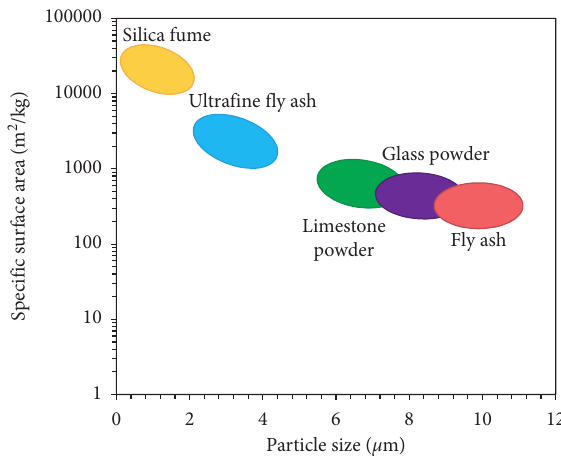
Figure 18: Particle size and specific surface area related to SCMs, based on data collected from relevant studies.